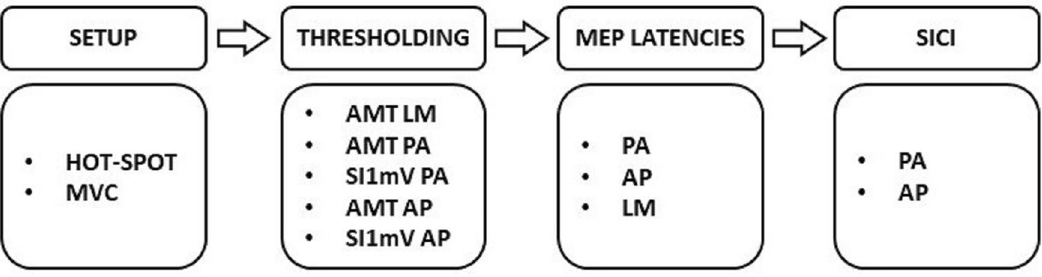
Figure 1. Experimental procedure. MVC maximum voluntary contraction, AMT active motor threshold, SI stimulus intensity, SICI short-interval intracortical inhibition, PA posterior–anterior, AP anterior–posterior, LM